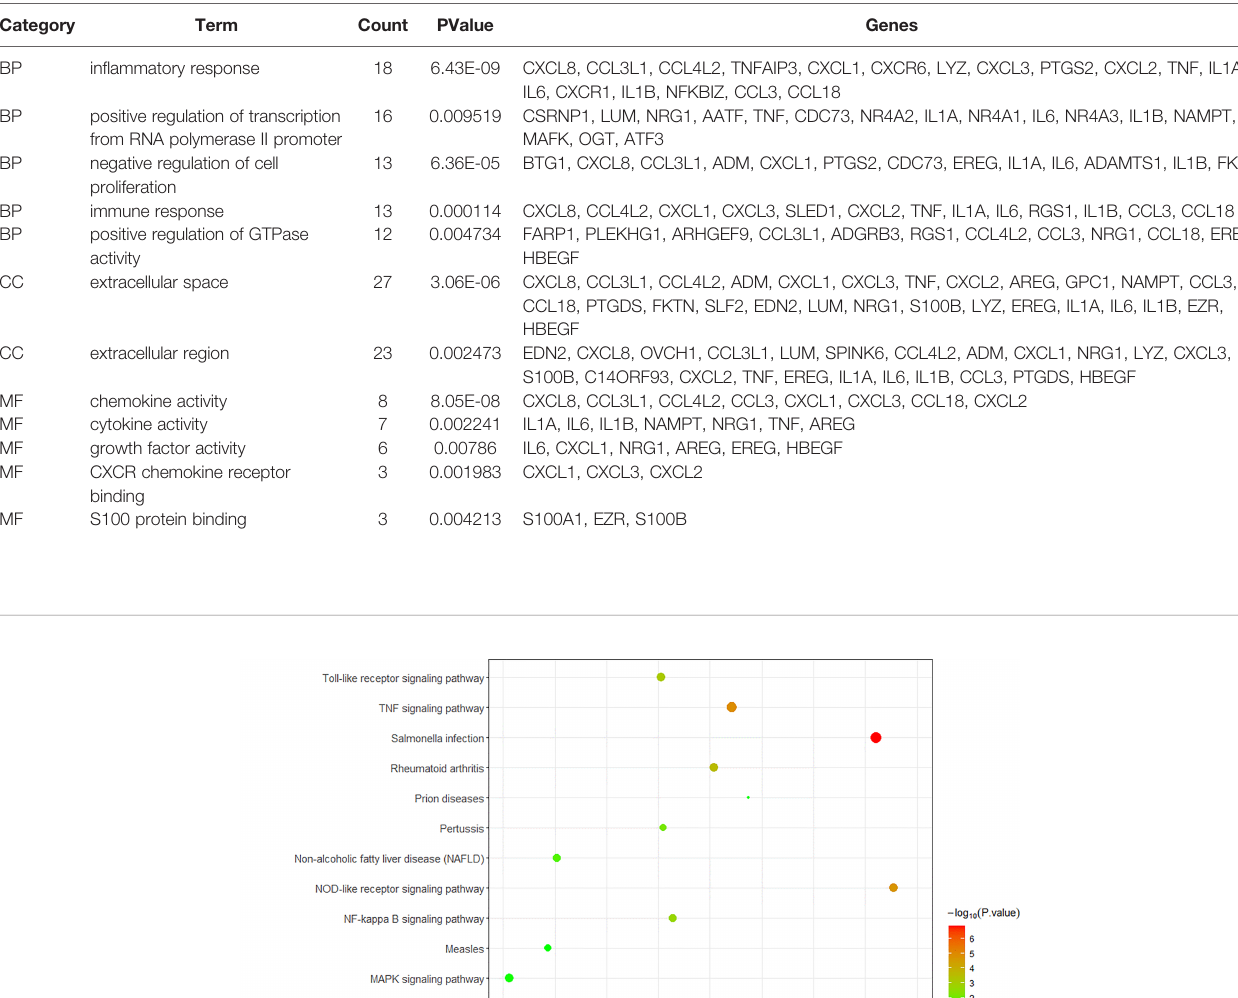
TABLE 1 | The results of GO of